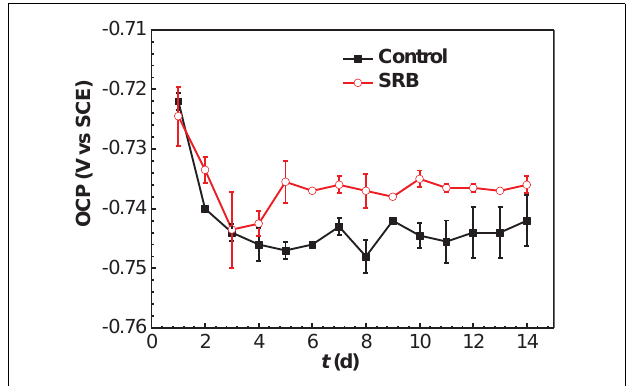
FIGURE 7 | Changes of OCP values with time in the absence and presence of SRB in CO 2 -saturated simulated formation water. (Error bars represent standard